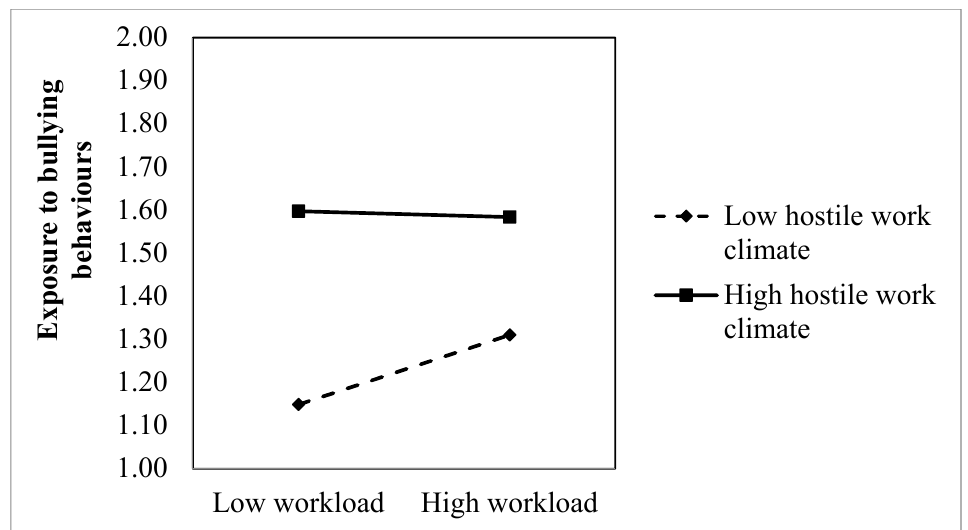
Figure 1. Plot of the interactive relationship of role conflict and bullying behaviours in departments with weak vs. a strong hostile work climate.